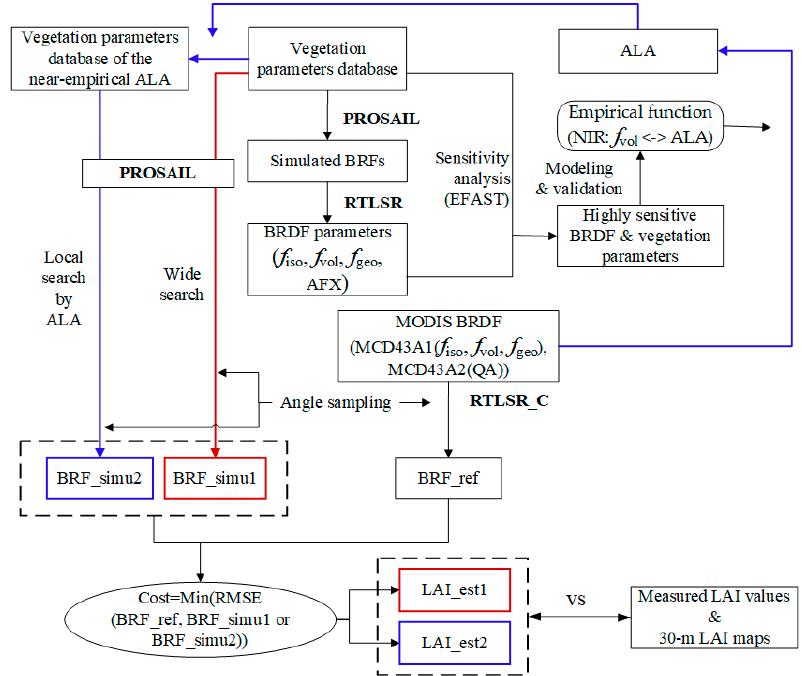
Figure 2. Flowchart of vegetation parameter estimation by linking the PROSAIL and Ross-Li BRDF models using the MODIS BRDF parameter product.